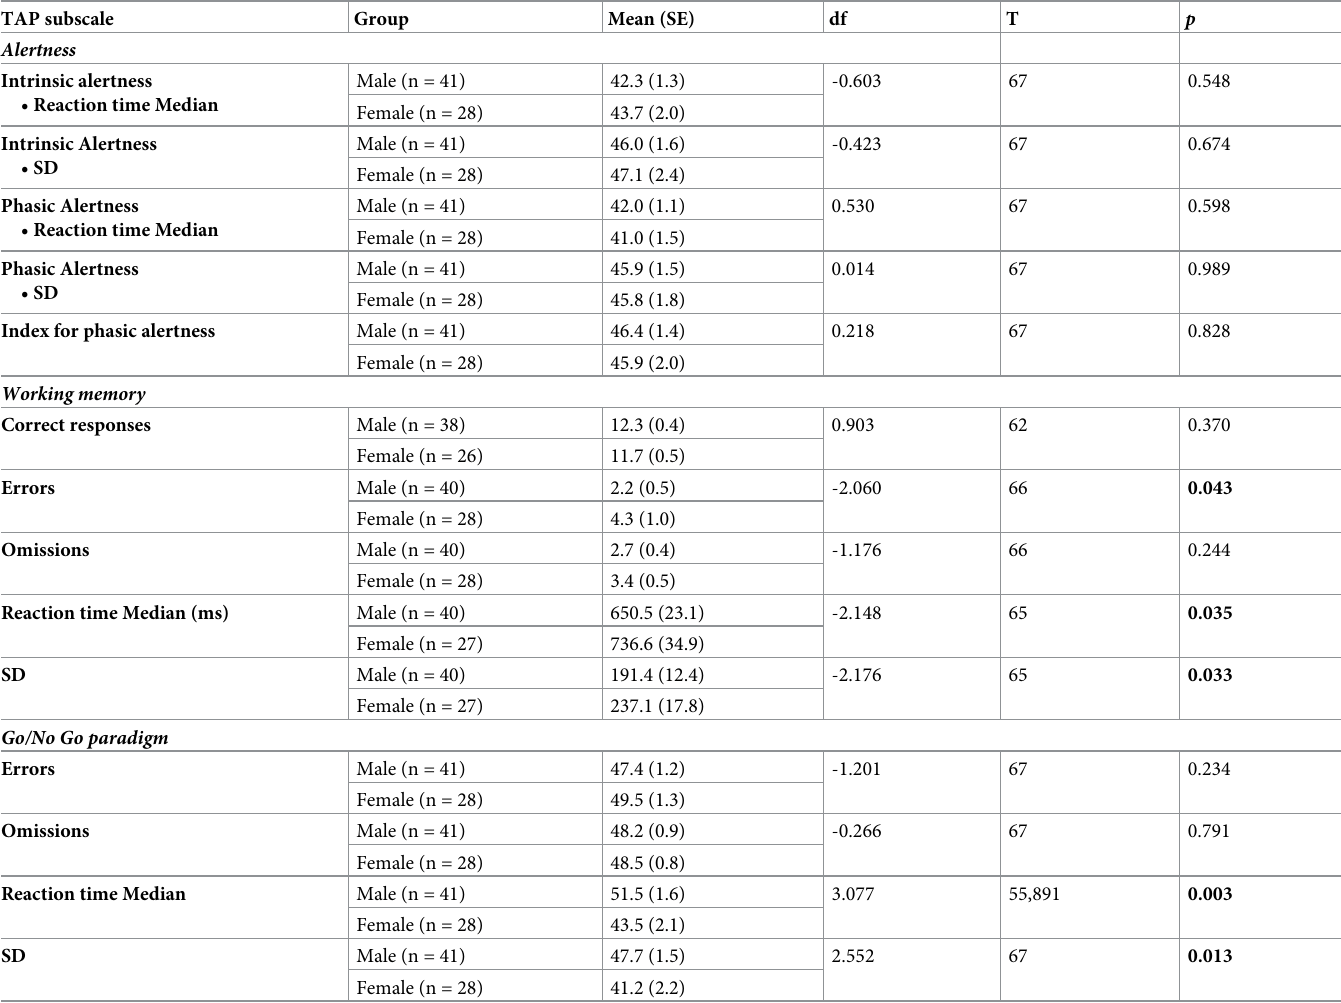
Table 3. Group differences between males and females in TAP subtests alertness, working memory and Go/No Go paradigm. TAP